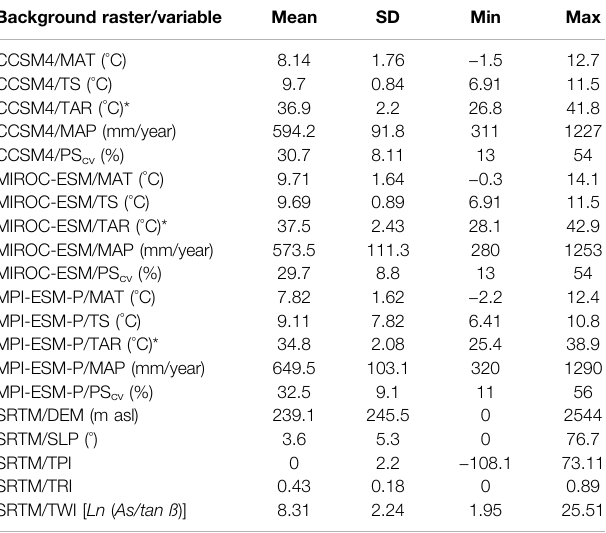
TABLE 2 | Summary statistics of the background raster datasets used for ECNM of the CTU and CTU groups. Background raster/variable